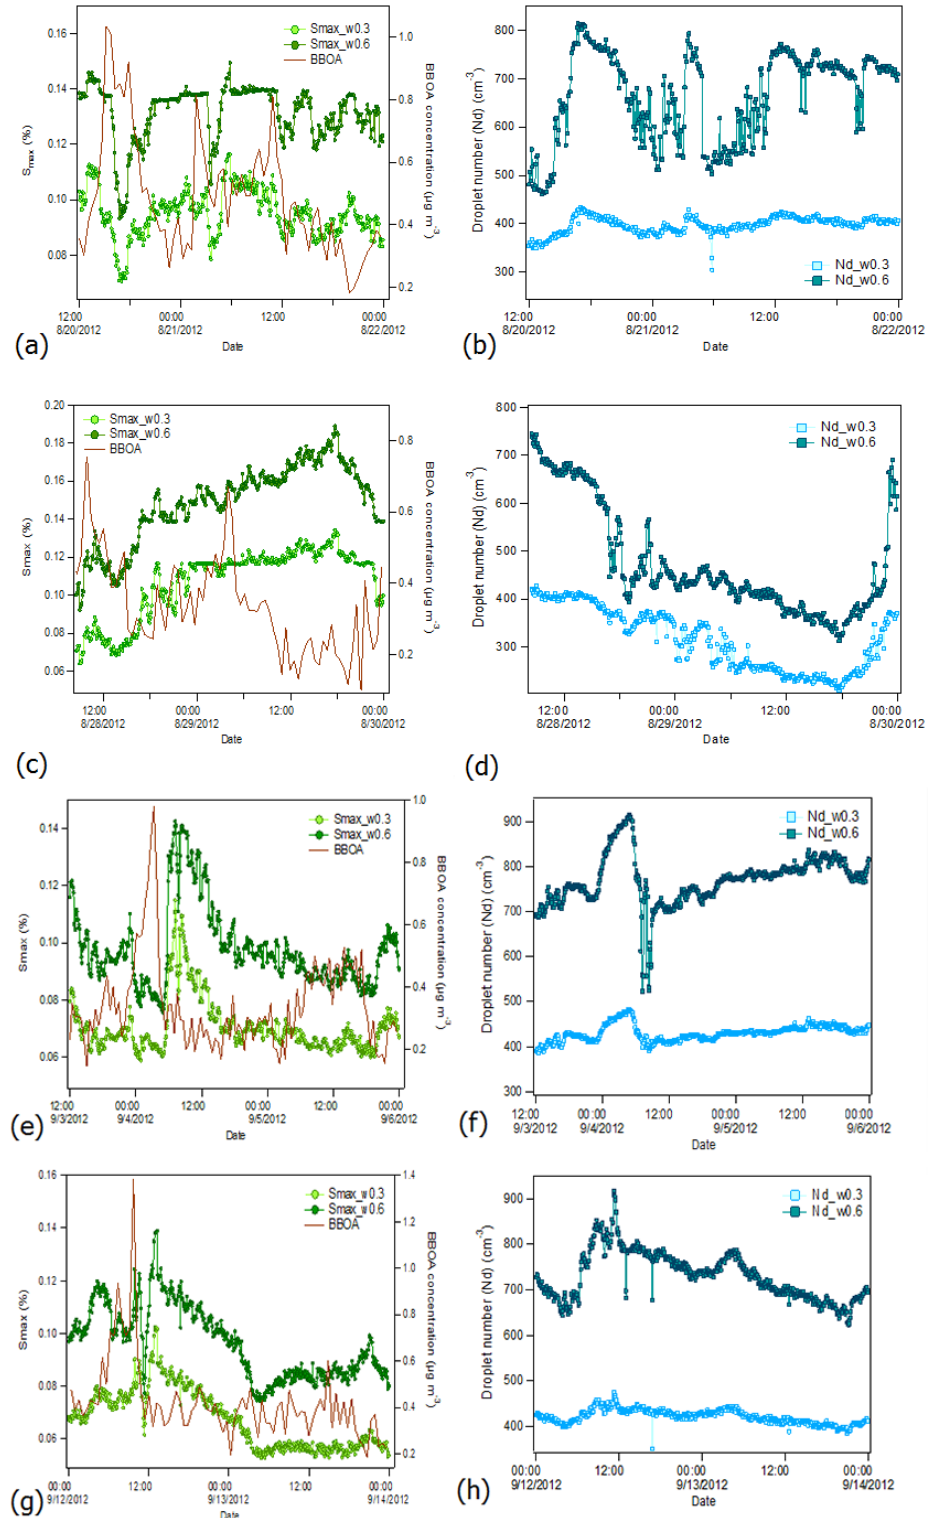
Figure 9. Maximum supersaturation ( S max ) (left panels) and potential droplet number ( N d ) (right panels) for the four fire events of Chios (a, b) , Croatia (c, d) , Euboea (e, f) and Andros (g, h)